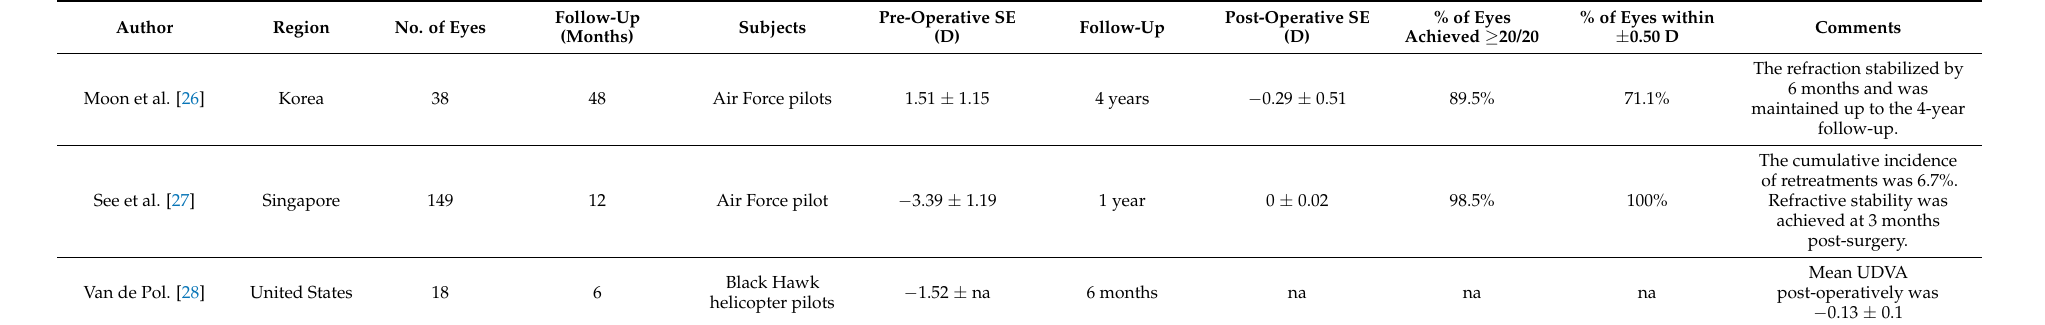
Table 2. Previous studies conducted on post-PRK combat